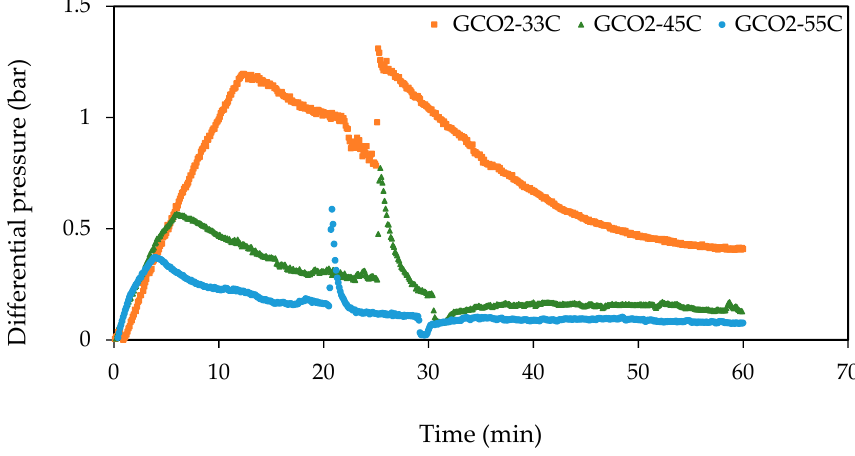
Figure 9. Effect of experimental temperature on the differential pressure profile of low-fluid-pressure GCO 2 –oil displacements conducted at 0.4 mL/min and 40 bar.